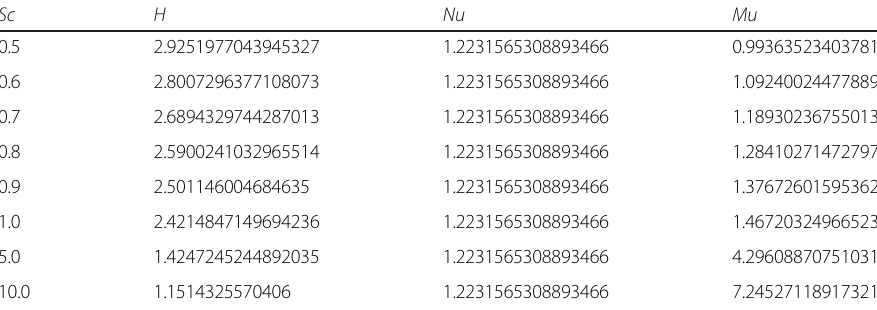
Table 5 Values of skin friction ( H ), Nusselt number ( Nu ), and Sherwood number ( Mu ) for different values of Sc Sc H Nu Mu